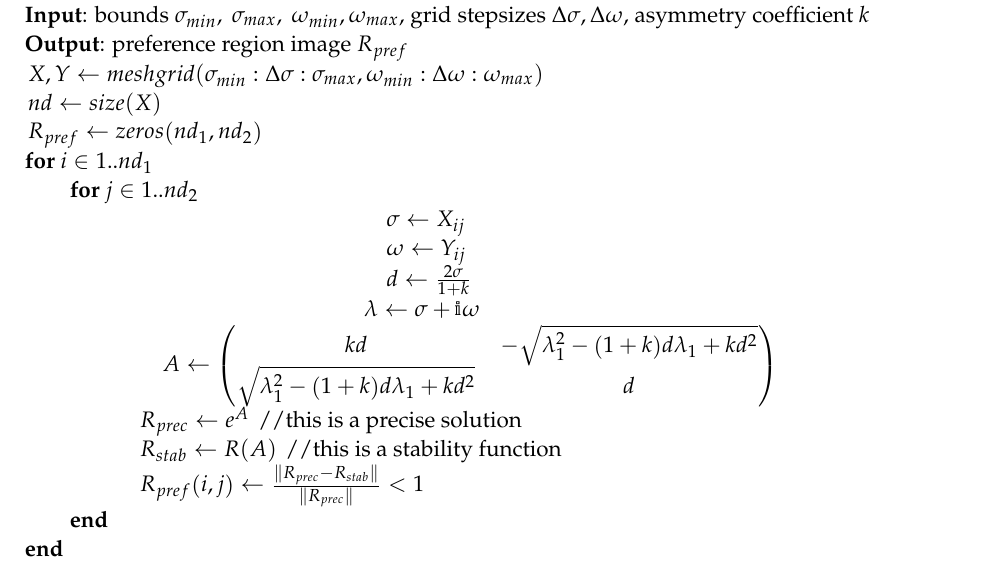
Algorithm 1: Plotting preference region for the one-dimensional test